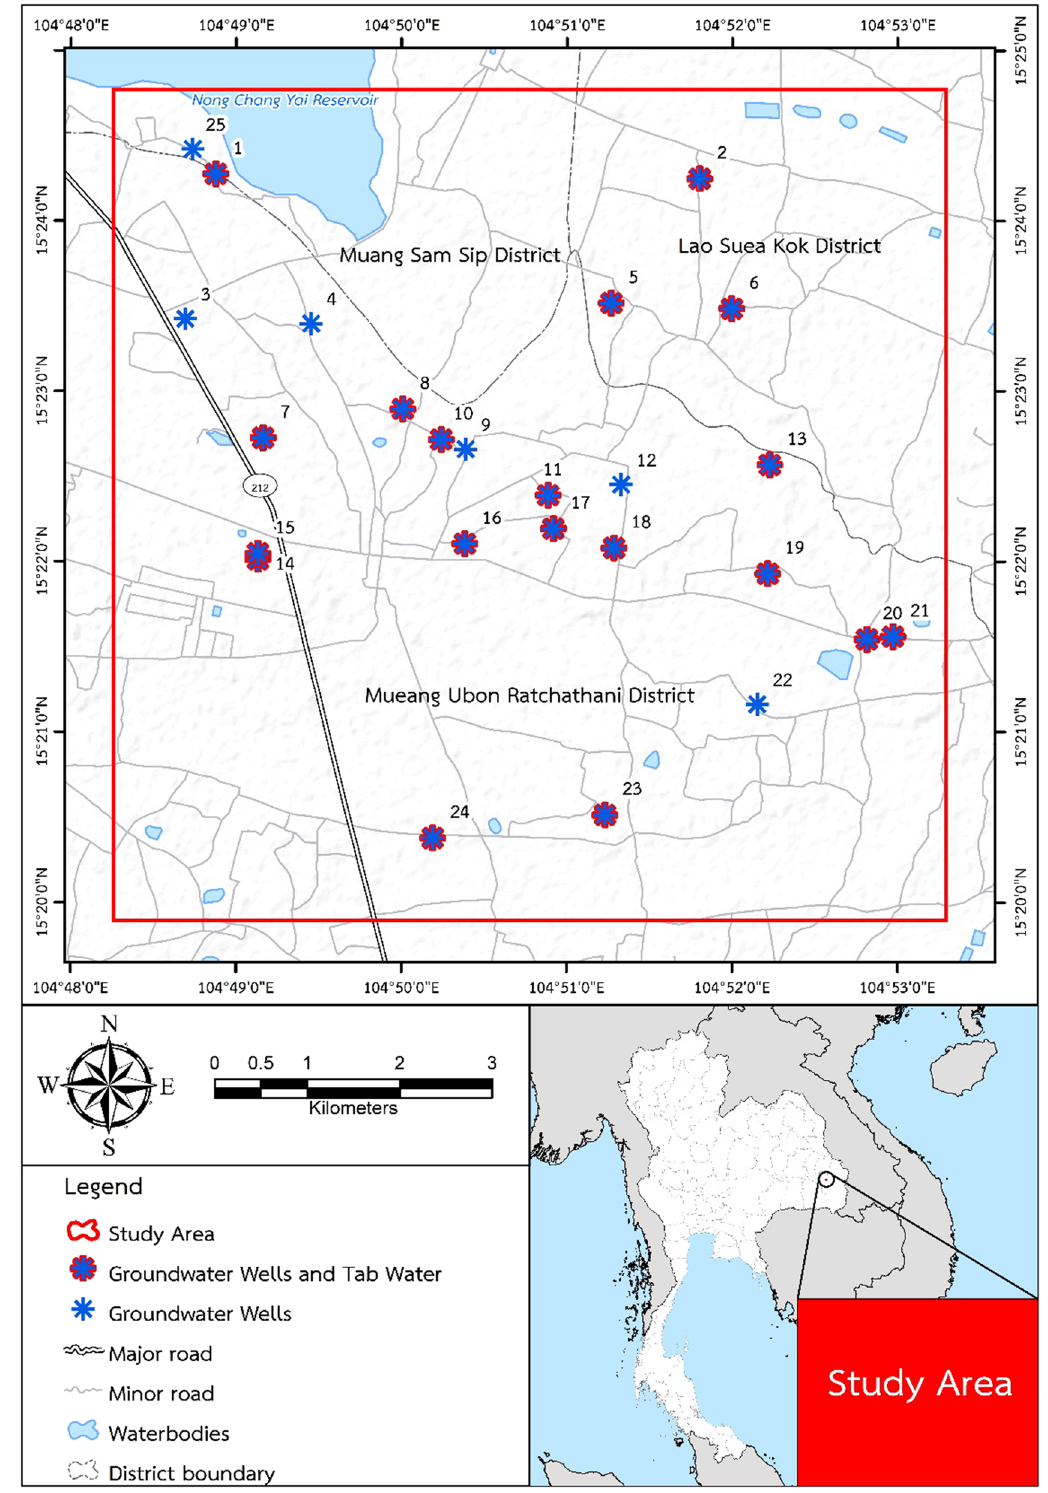
Figure 1. Study area location in Ubon Ratchathani, Thailand, showing the 25 groundwater well stations and those where residents has access to tap water as well (adapted from 34 , Springer Nature, Environmental Geochemistry and Health, by Wongsasuluk et al. Copyright